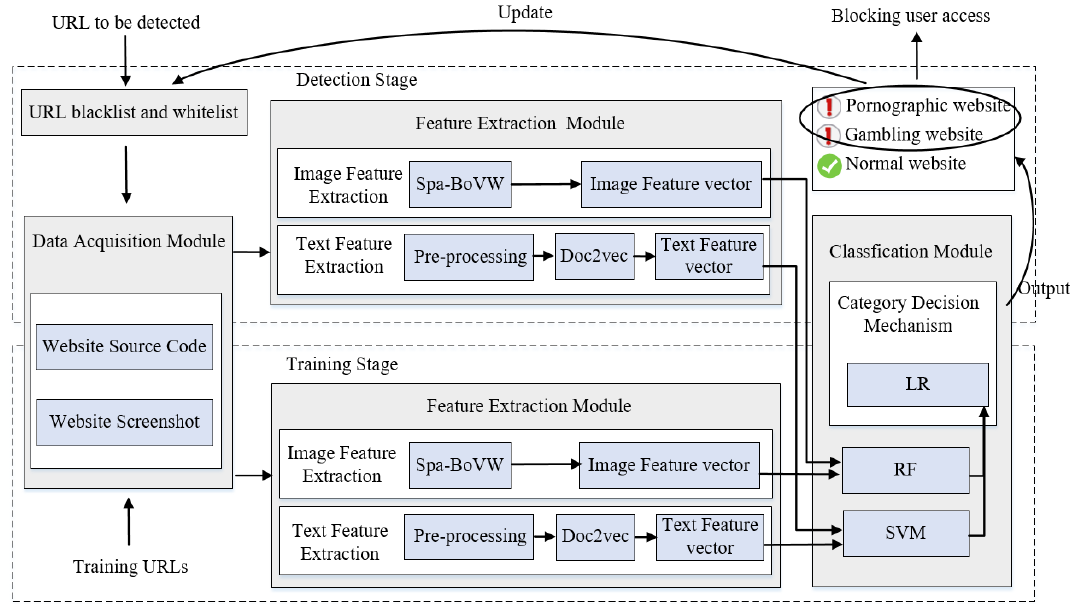
Figure 2. Overall framework of the proposed system. LR: Logistic regression, RF: Random forest, Spa-BOVW: Spatial bag-of-visual-words, SVM: Support vector machine.